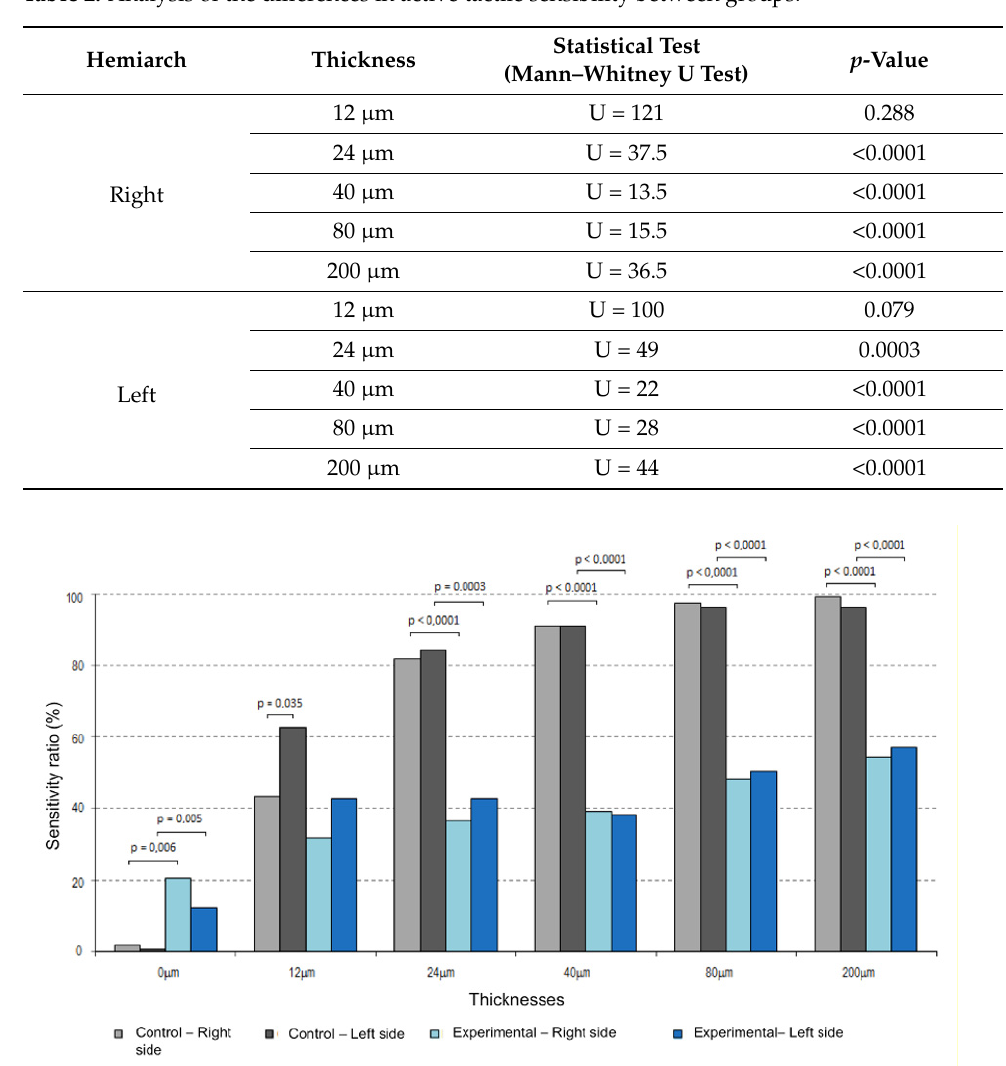
Table 2. Analysis of the differences in active tactile sensibility between groups.